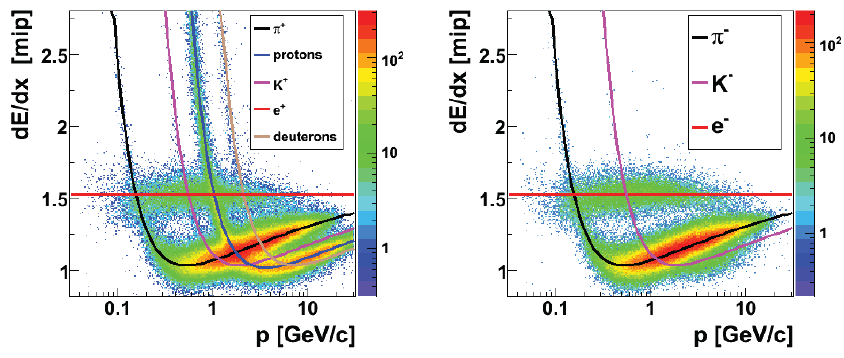
Figure 2. The specific energy loss in the TPCs for positively (left) and negatively (right) charged particles as a function of momentum. Curves show parameterizations of the mean dE / dx calculated for di ff erent particle species.